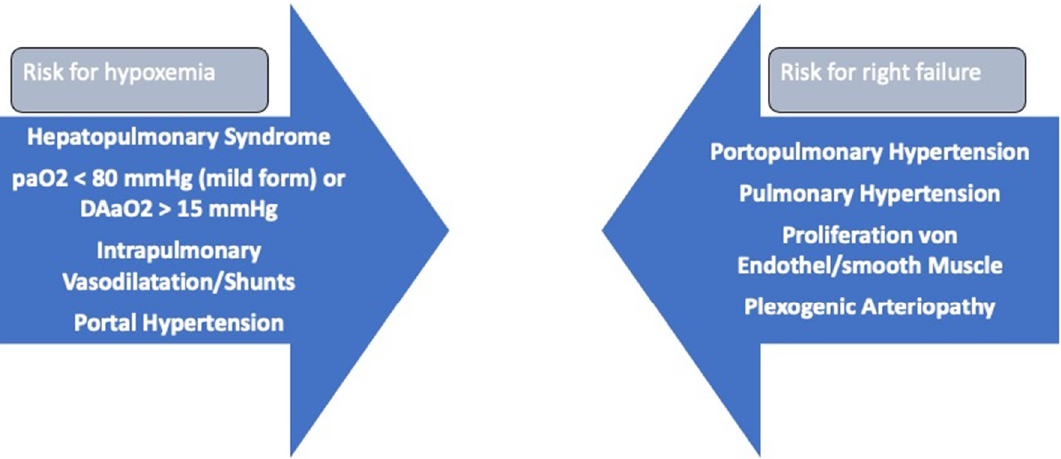
Figure 2. Comparison Hepatopulmonary syndrome and Portopulmonary hypertension.